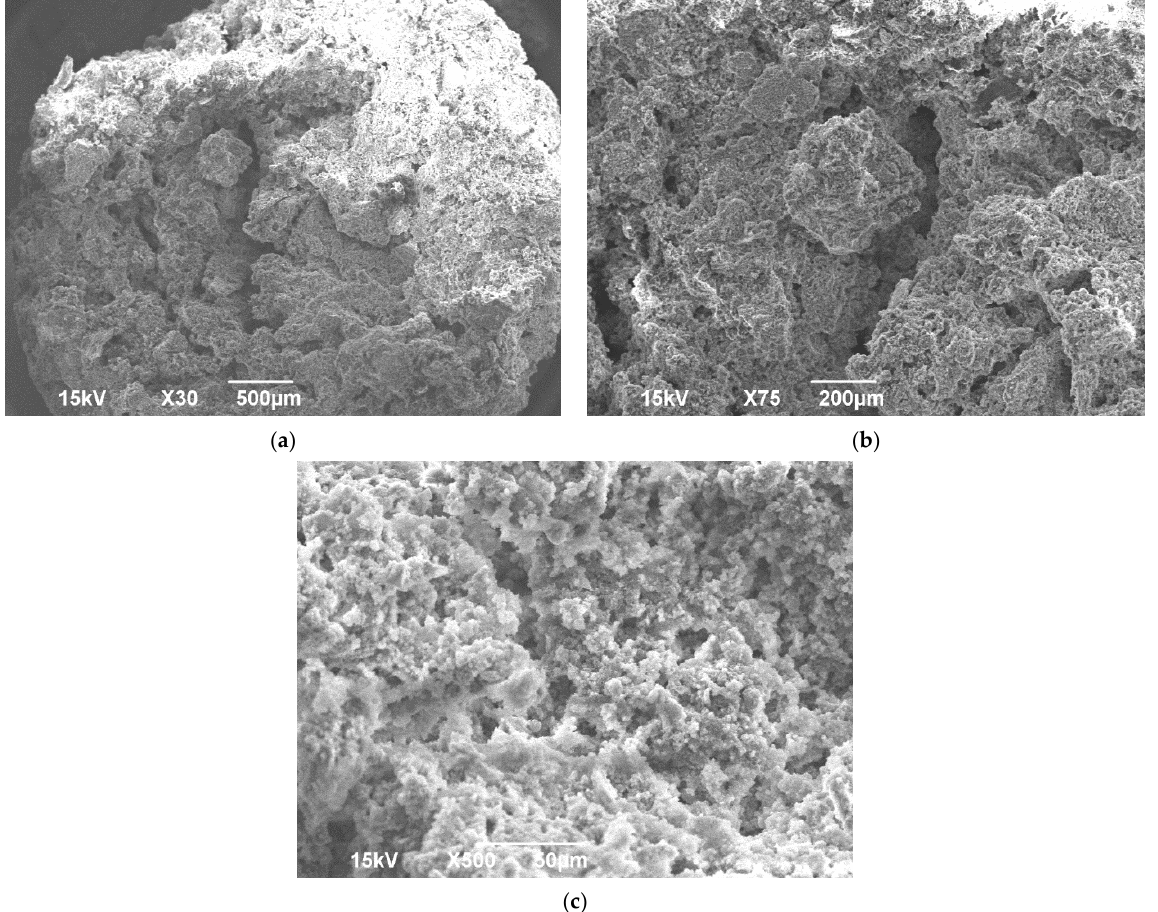
Figure 6. SEM showing the ( a ) outer structure of the ABVF-BG putty and ( b ) and ( c ) inner porous structure. 2.3. Micro-Computed Tomograpgy ( µ -CT) of ABVF-BG Putty µ -CT was done on the ABVF-BG putty to assess the distribution of BG particles in the polymer matrix of ABVF-BG. µ -CT of the ABVF-BG putty showed a homogenous distribution of BG particles embedded in the polymer matrix (Figure 7). The BG particles occupy 53.46% ( v/v ) volume in the ABVF-BG polymer matrix.